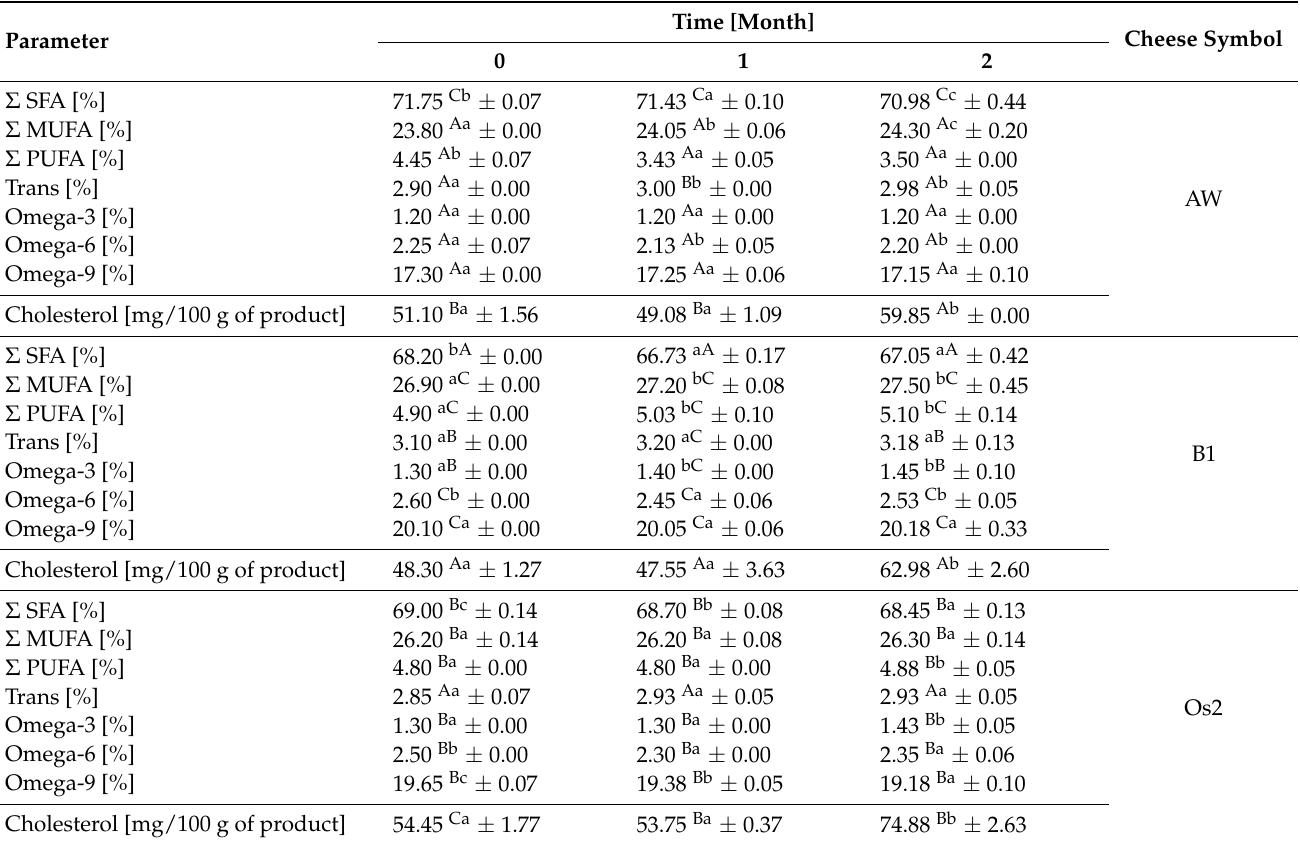
Table 3. Selected fatty acid composition, sums and cholesterol content in goat’s acid-rennet cheeses after production, and after 1 and 2 months of